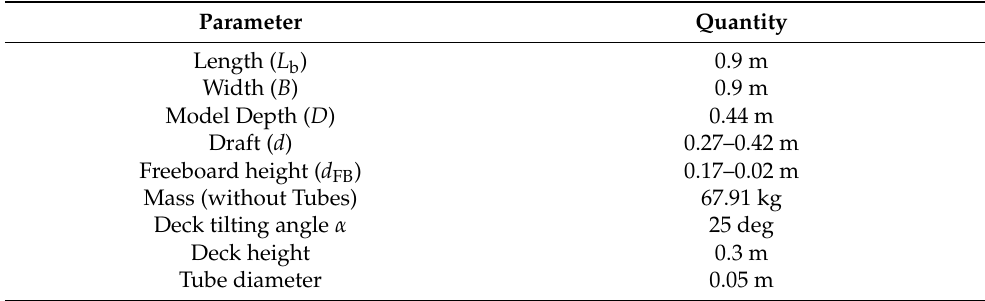
Figure 4. Test model fixed from motion by frames and iron bars as viewed from the back. Table 1. Model geometry and dimensions, reprinted with permission from [25], 2022, Elsevier, License